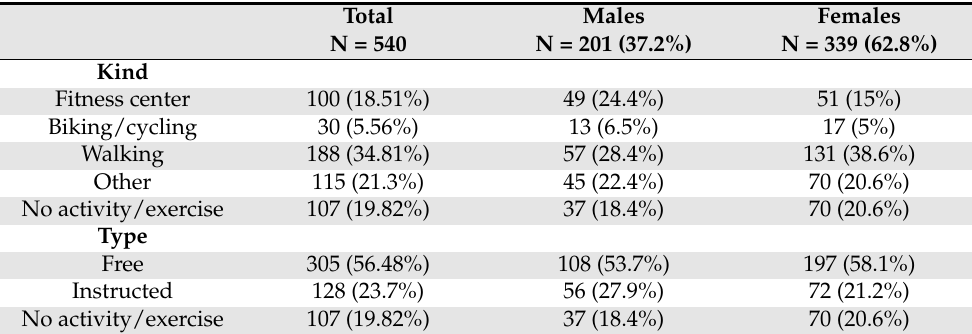
Table 8. Physical activity-exercise of the study